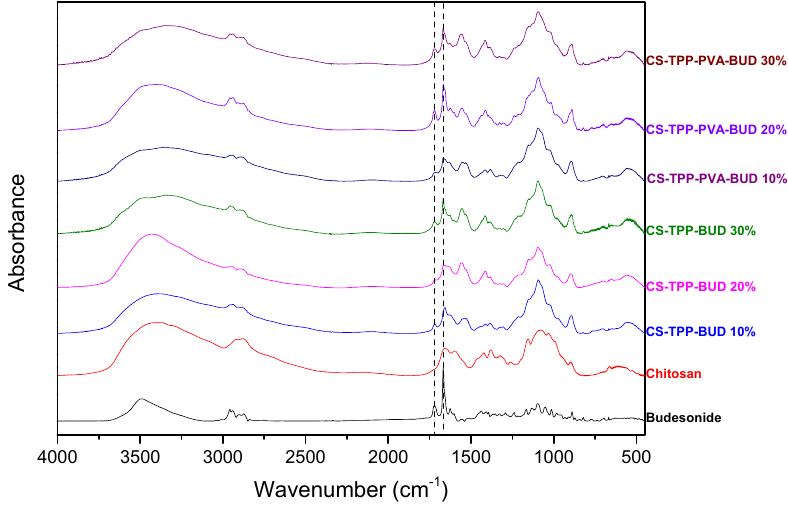
Figure 4. FTIR spectra of CS nanoparticles containing BUD in different ratios 10%, 20%, 30% w/w.